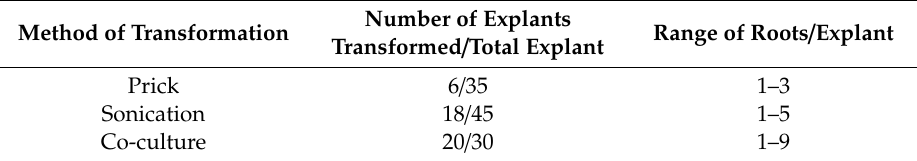
Table 1. Hairy root formation on Helianthella quinquenervis leaf explants 40 days after transformation with A.